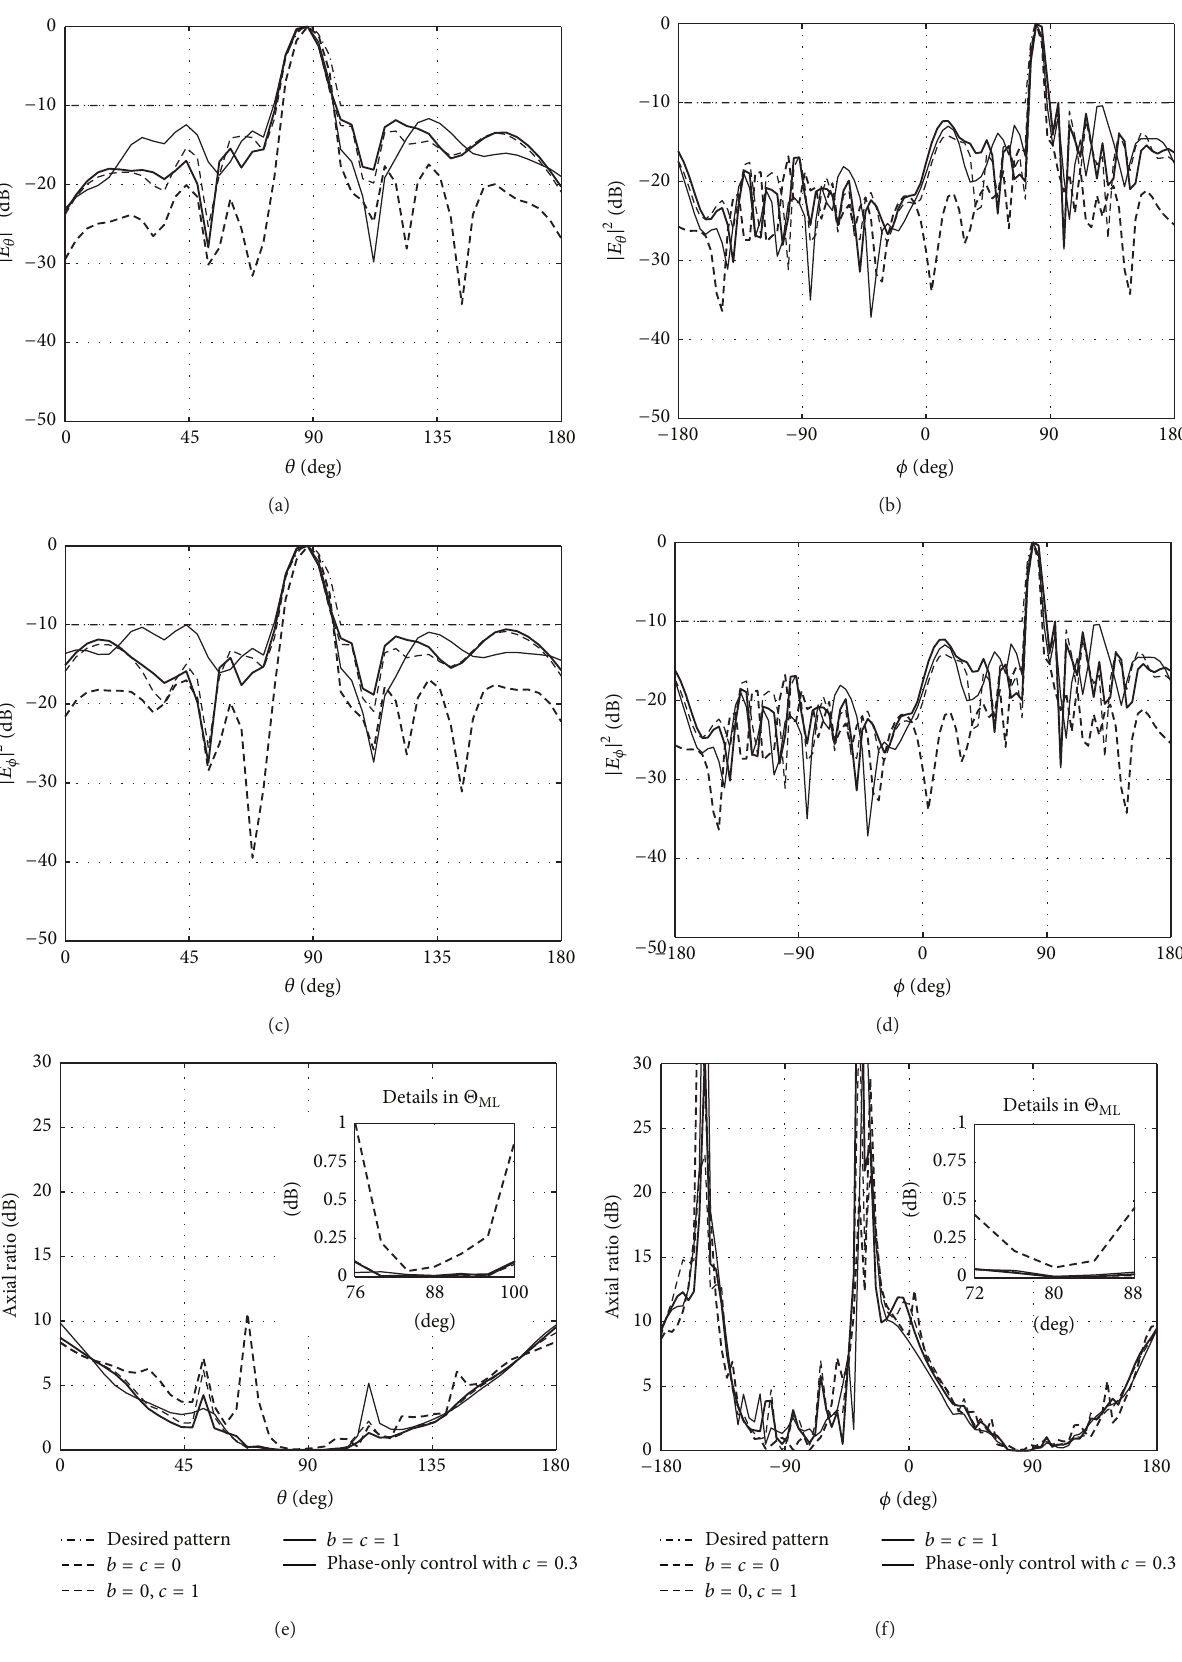
Figure 2: Patterns and axial ratios obtained using the proposed algorithm: (a) |𝐸 𝜃 | 2 for 𝜙 = 𝜙 0 = 80 ∘ , (b) |𝐸 𝜃 | 2 for 𝜃 = 𝜃 0 = 88 ∘ , (c) |𝐸 𝜙 | 2 for = 80 ∘ , (d) |𝐸 | 2 for 𝜃 = 𝜃 = 88 ∘ , (e) axial ratio for 𝜙 = 𝜙 𝜙 = 𝜙 0 𝜙 0